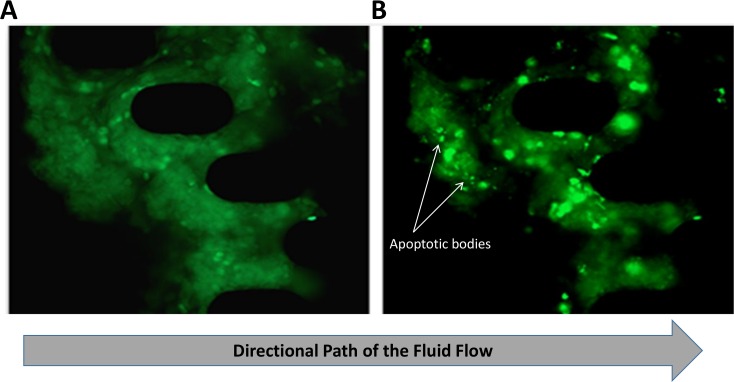
Assessment of small molecule drug perfusion in a tumor FNA fragment using Doxorubicin HCL.(A) Drug perfusion after an 8-hour period showing distribution of drug indicated by green fluorescent intensity spatially similar throughout the FNAB tissue sample. (B) Drug perfusion after a 24-hour period showing intensity peaks spatially similar throughout the FNAB tissue sample and the formation of apoptotic bodies.